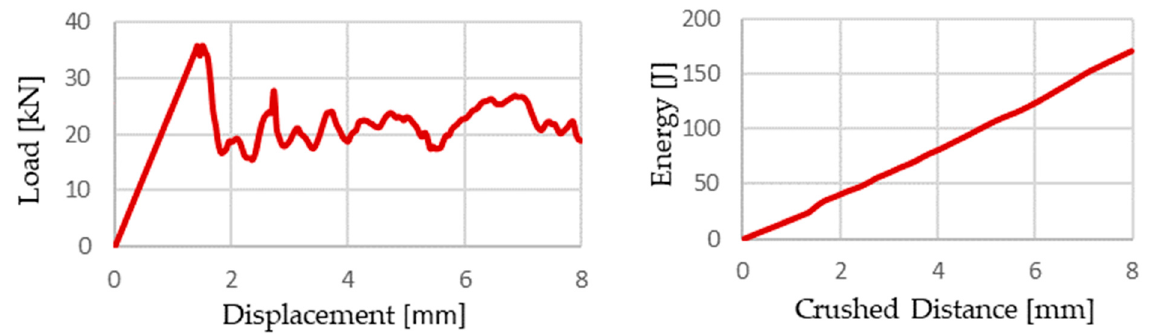
Figure 20. Simulation results of the sinusoidal structure with 7 curvatures: load-displacement curve ( left ) and energy curve ( right ).